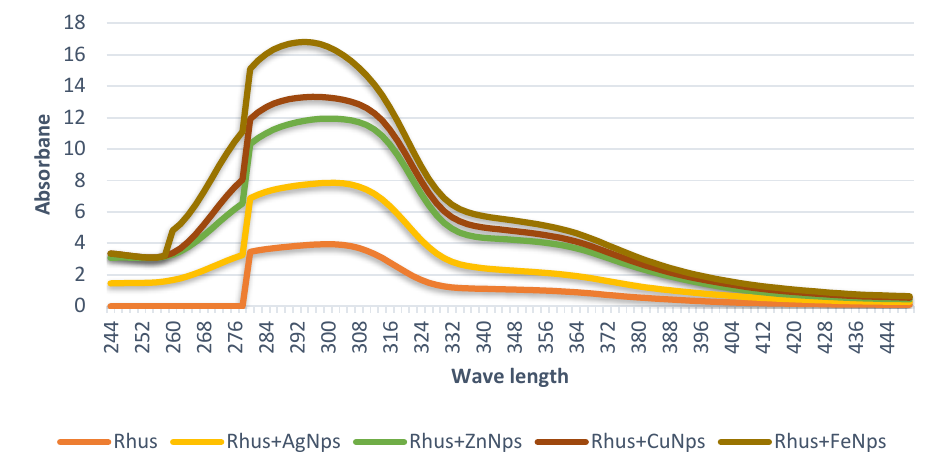
Figure 2. UV–Vis spectroscopic measurements of rhus and its prepared metal nanoparticles.